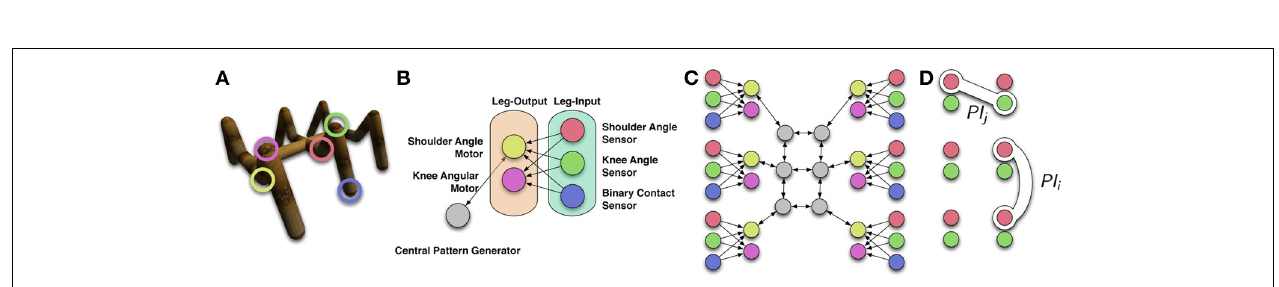
FIGURE 3 | Results for cart-pole experiments. Each row shows the results for one controller architecture, see Figure 2 . The corresponding connection matrix is provided in the first column (gray: connection, black: no connection). For simplicity only the row